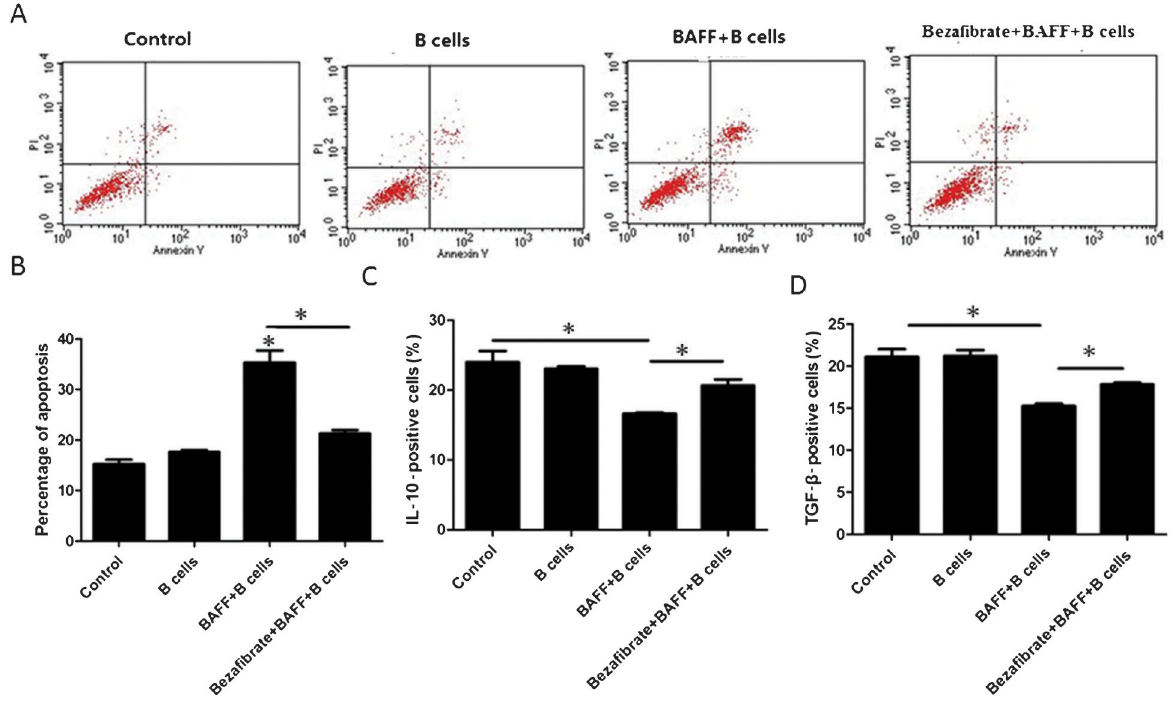
Figure 4. B-cell-activating factor (BAFF) induces regulatory T cell (Treg) apoptosis and cytokine expression through B cells. A , CFSE- labeled Tregs were co-cultured with B cells with or without 40 ng/mL BAFF and 40 mg/mL bezafibrate for 48 h and Treg apoptosis was then analyzed by annexin-V-PI (propidium iodide) staining. B , The percentage of cell apoptosis was analyzed statistically. C , CFSE- labeled Tregs were co-cultured with B cells with or without 40 ng/mL BAFF and 40 mg/mL bezafibrate for 48 h and IL-10 was then tested by flow cytometry. D , CFSE-labeled Tregs were co-cultured with B cells with or without 40 ng/mL BAFF and 40 mg/mL bezafibrate for 48 h and TGF- b was then tested by flow cytometry. Data are reported as means ± SE of replicates from a sample of an individual donor for three representative independent experiments. *P , 0.05 vs control (one-way ANOVA followed by the Student- Newman-Keuls multiple comparisons could provide some suggestions for PBC treatment. cells from PBC patients. BAFF had no direct effect on Treg apoptosis or cytokine secretion. However, BAFF can induce Treg cell apoptosis and reduce IL-10 and TGF- b expression via B-cell activation. Bezafibrate can inhibit Treg suppression by BAFF-activated B cells. Our study